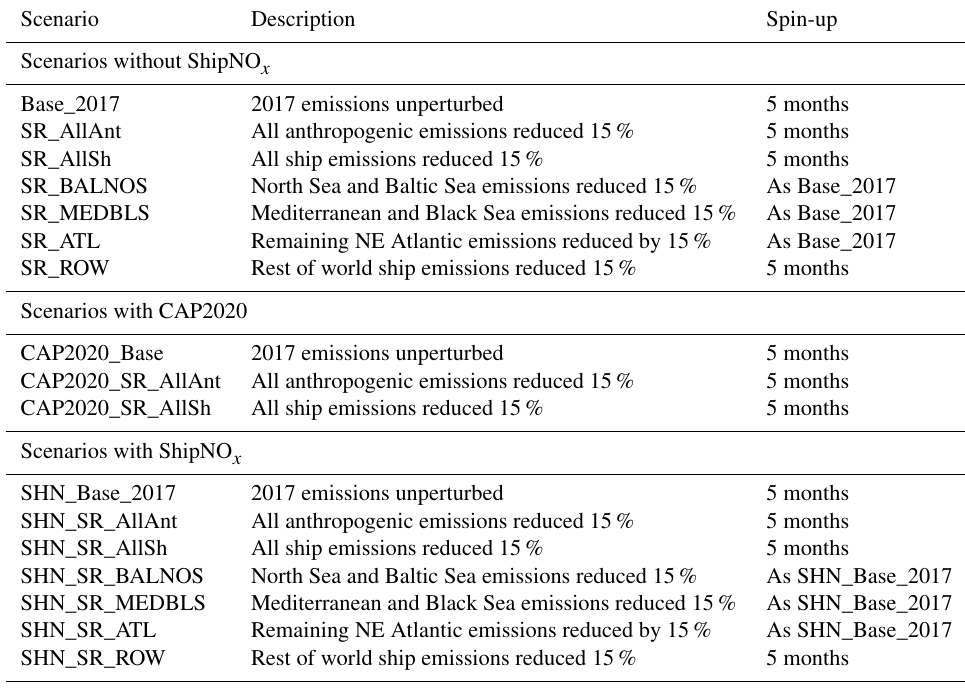
Table 2. Overview of model scenarios used. Separate model spin-up was only performed for Base model run(s) and for model runs with globally perturbed emissions. For SR (source receptor) model runs perturbing limited areas, we use the same spin-up as for the Base runs. CAP2020 emissions are estimated by scaling the emissions outside the North Sea and Baltic Sea SECAs from an assumed